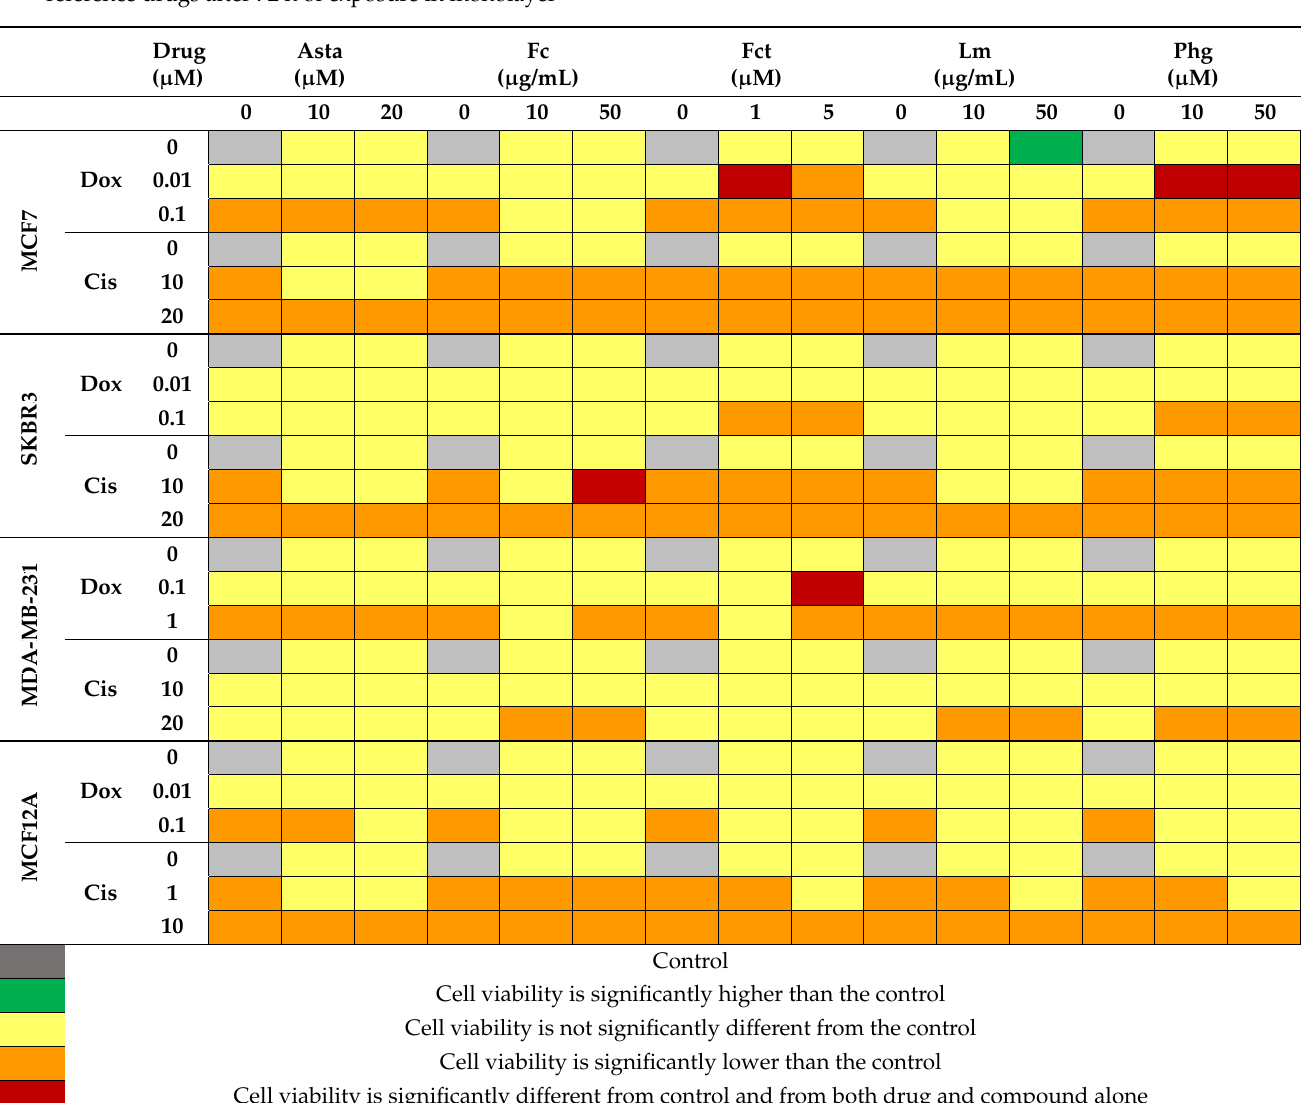
Table 3. Summary of the results on cell viability assessed by MTT of the combination seaweed bioactive compound and reference drugs after 72 h of exposure in